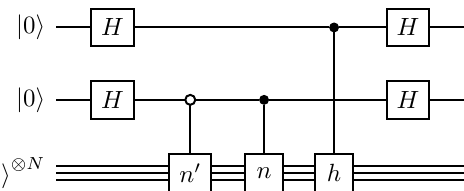
Figure 2. Quantum circuit for indirect measurement of the real and imaginary parts of an arbitrary ˆ h n (cid:48) element s | n (cid:105) , for a given Pauli string operator (cid:104) | The first control qubit from the top is used for the measurement of the operator ˆ h s . The second control is to prepare the quantum state of the target